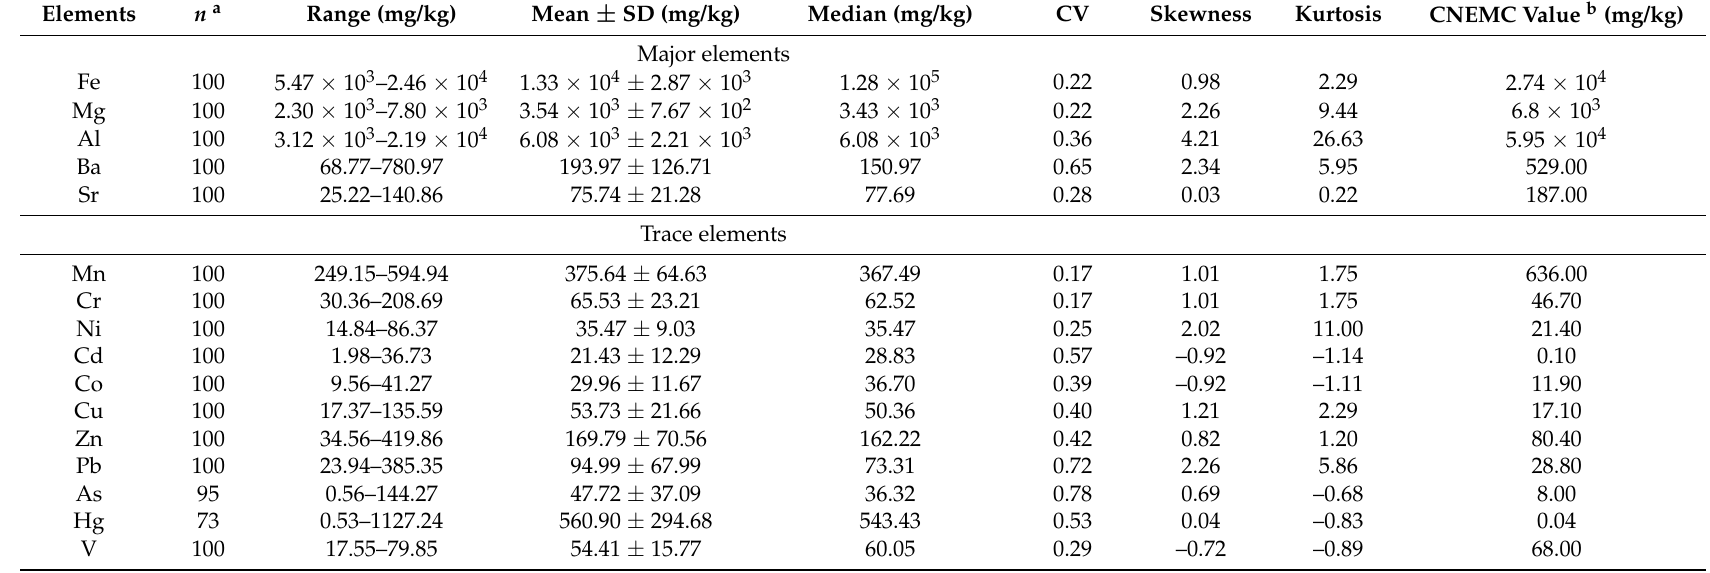
Table 3. Metal concentrations and summary statistics (mg/kg).